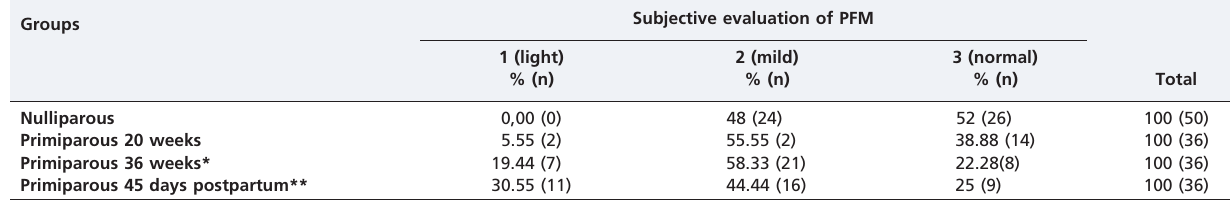
Table 2 - Results of a subjective evaluation of anterior PFM strength in the nulliparous compared to the primiparous group at different time points using the classification system of Amaro et al. 8